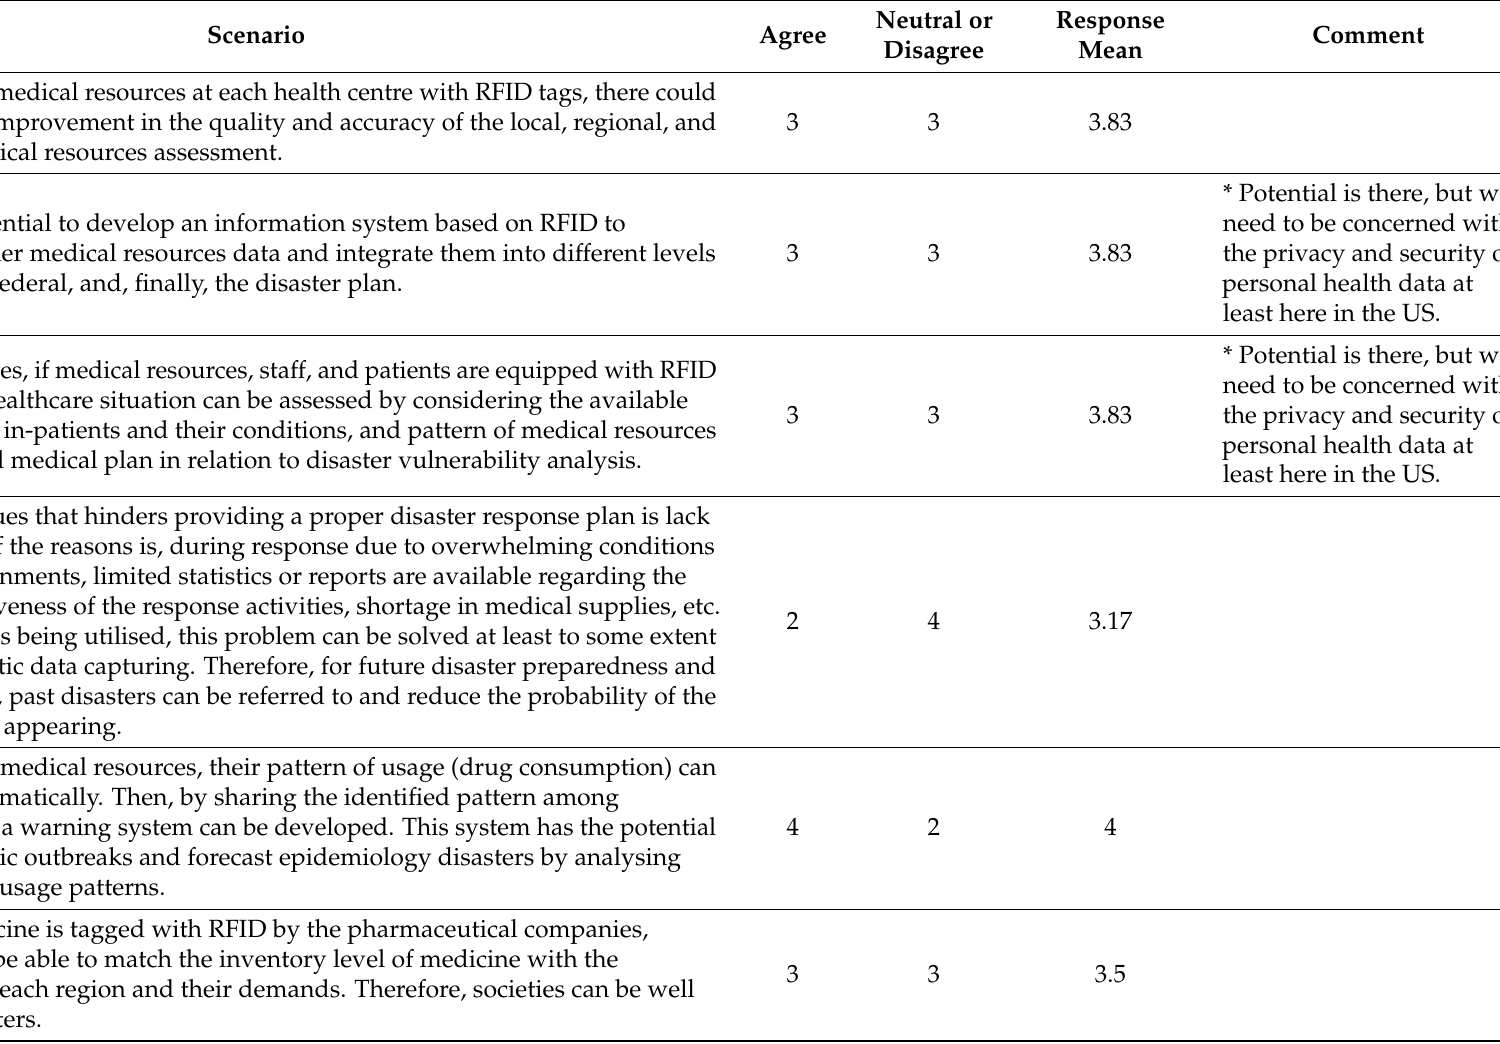
Table 4. Round 2 of RFID scenario applications in DMC and experts’